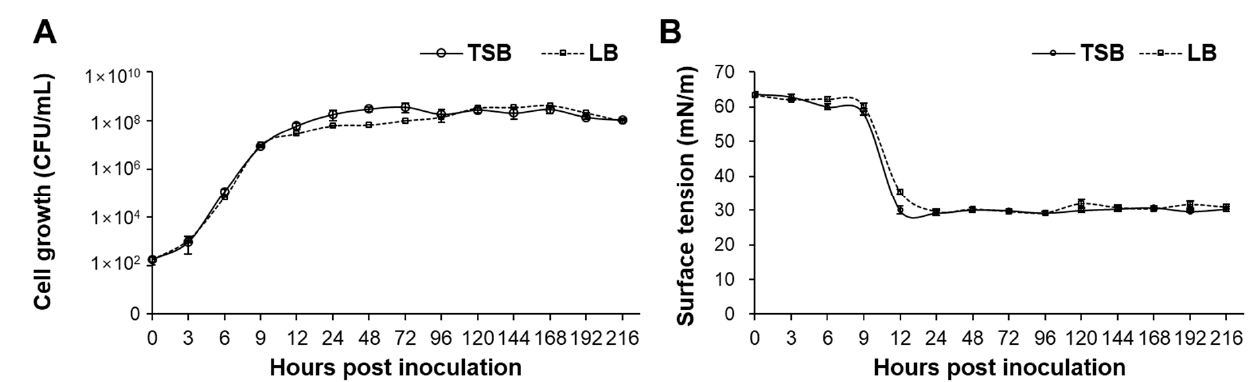
Figure 1. Characterization and identification of strain KB21. Neighbor-joining tree showing phylo- genetic positions of strain KB21 and representatives of related taxa, based on 16S rRNA gene se- quences. Bootstrap values (expressed as percentages of 1000 replications) are shown at branch points.